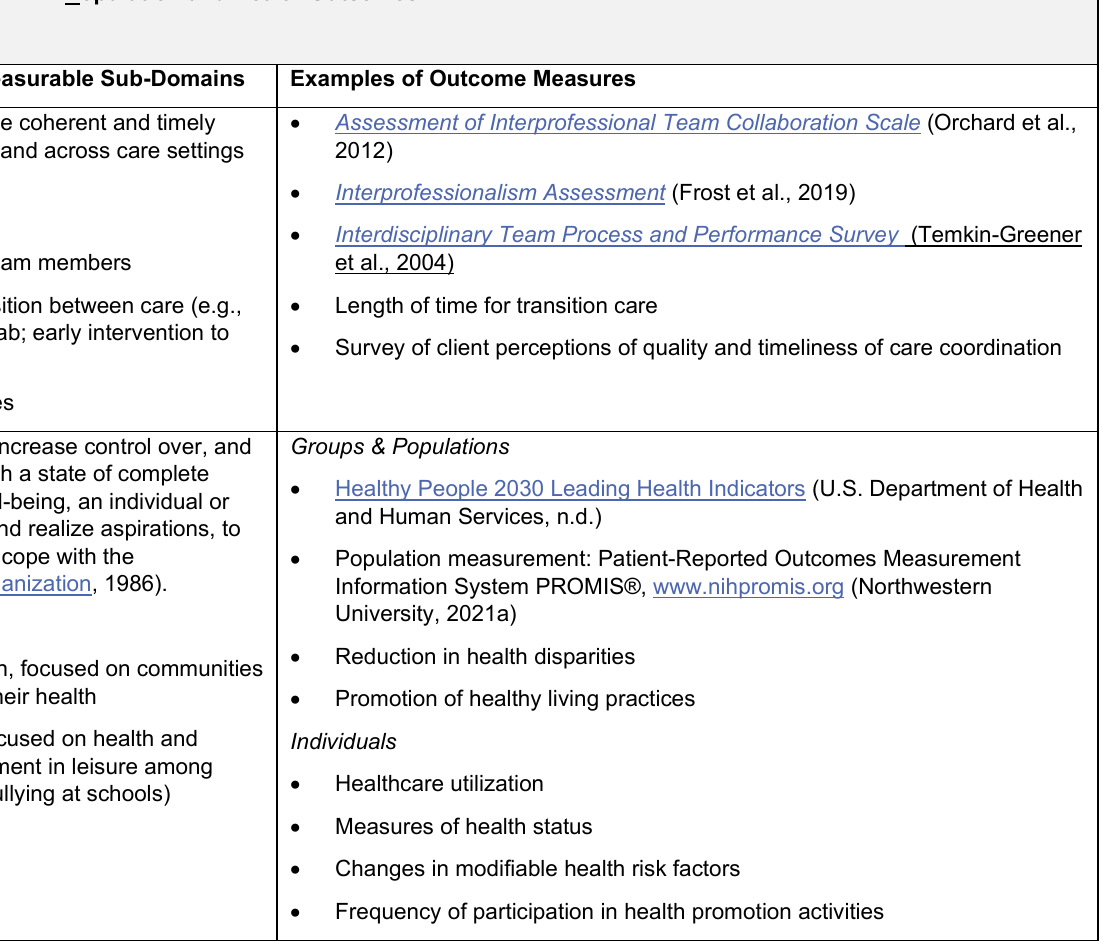
Table 3 The PACE Framework